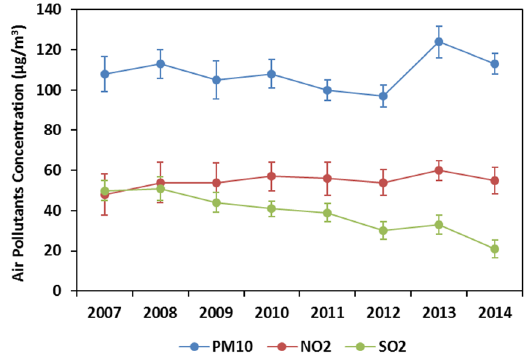
Figure 2. Inter-annual variation of SO 2 , NO 2 , PM 10 concentrations in Wuhan city from 2007 to 2014.